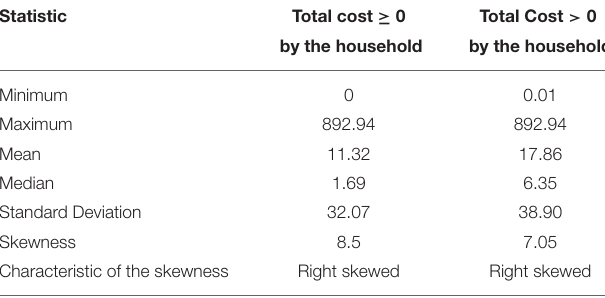
TABLE 3 | Summary of total costs of outpatient care incurred by households from the KHHEUS 2018.